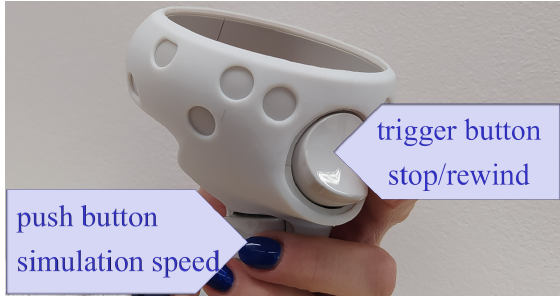
Figure 5. Oculus Quest 2 controllers with buttons used to control the simulation speed.